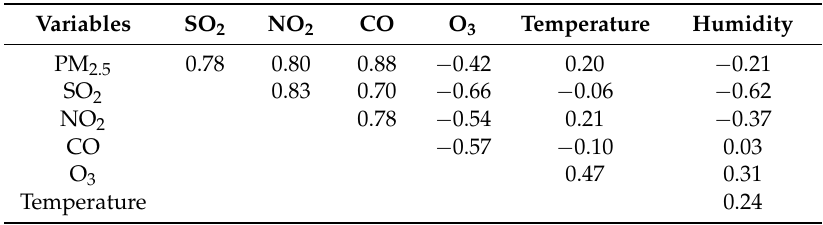
Spearman correlation coefficients between daily air pollutant concentrations and weather